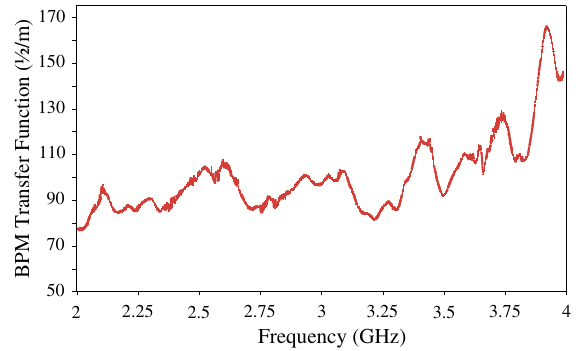
FIG. 11. (Color) FFT power spectrum for 6th, 8th, and 9th